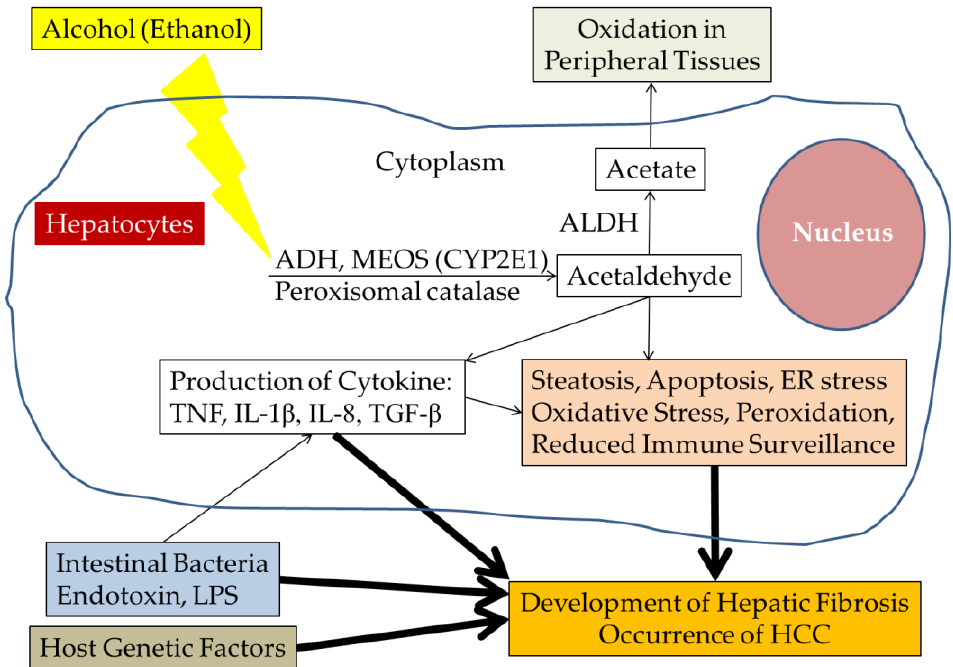
Figure 1. Schematic presentation depicting potential steps leading to liver pathogenesis from alcohol abuse. ALDH, aldehyde dehydrogenase; ADH, alcohol dehydrogenase; MEOS, microsomal ethanol-oxidizing system; CYP2E1, cytochrome P450IIE1; TNF, tumor necrosis factor; IL-1ß, interleukin-1ß; IL-8, interleukin-8; TGF-ß, transforming growth factor β1; ER, endoplasmic reticulum; LPS, lipopolysaccharide; HCC, hepatocellular carcinoma.